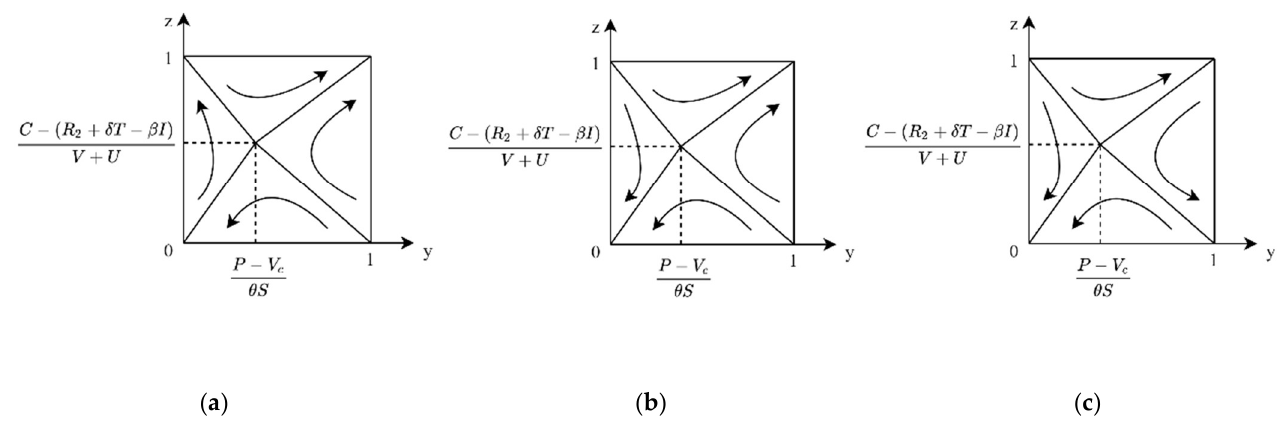
Figure 6. Evolutionary phase diagram of cost–benefit of enterprise under 0 < C - (R 2 + δT + βI) ( a ) When the price is lower than the product value. ( b ) When the price is slightly higher than the product value. ( c ) When prices are much higher than the product value.